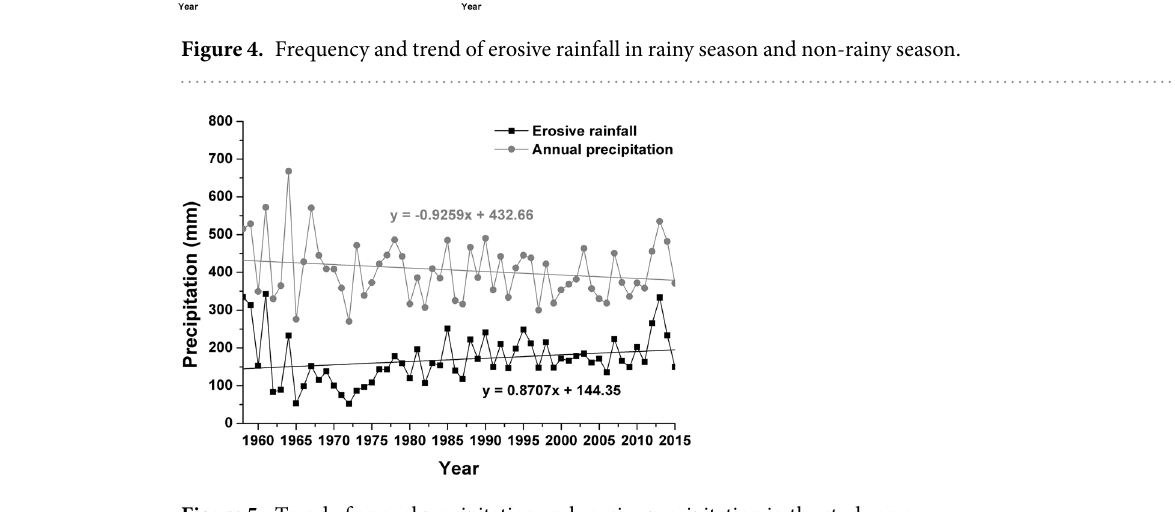
Study Methods Standardized precipitation index.